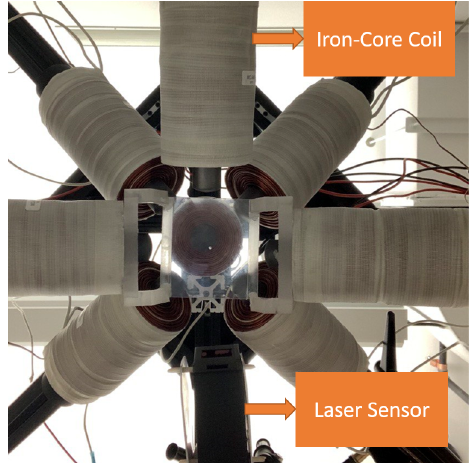
Figure 1. Magnetic manipulator consist of eight iron-core